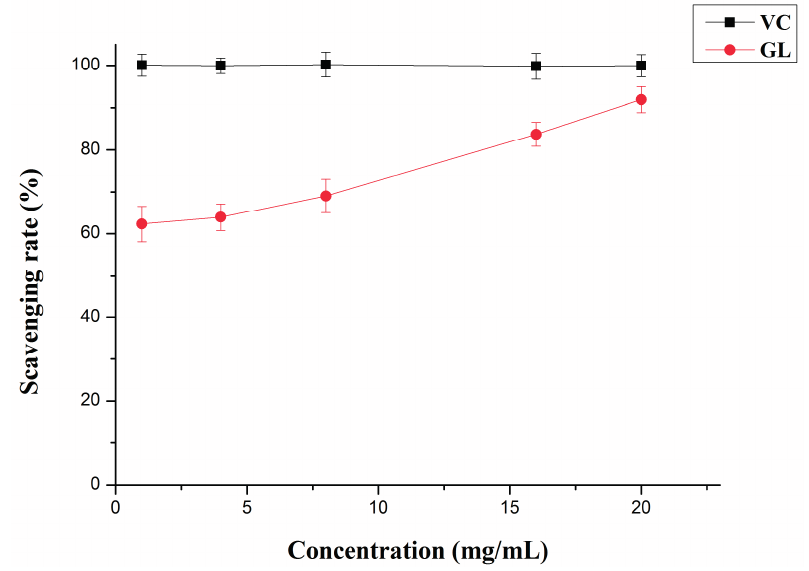
Figure 4. Hydroxyl radical scavenging activity of GL polysaccharides and VC. Data are mean ± SD ( n =